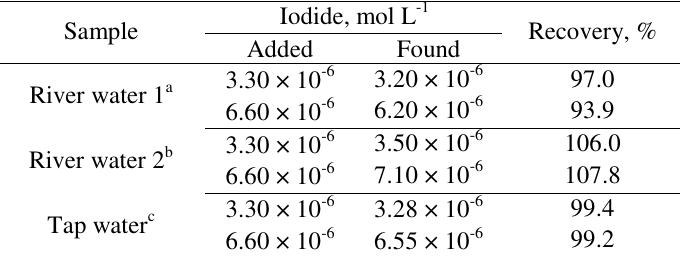
Table 4. Determination of iodide in real